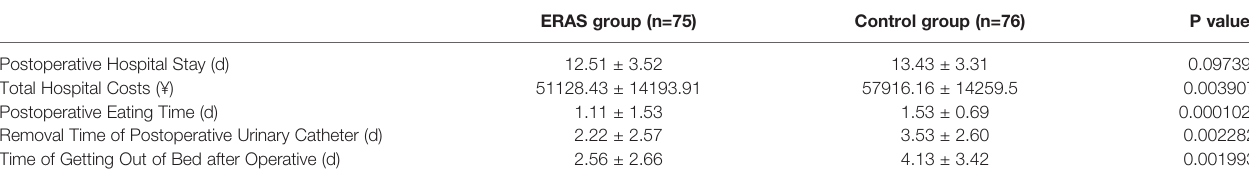
TABLE 1 | Clinical